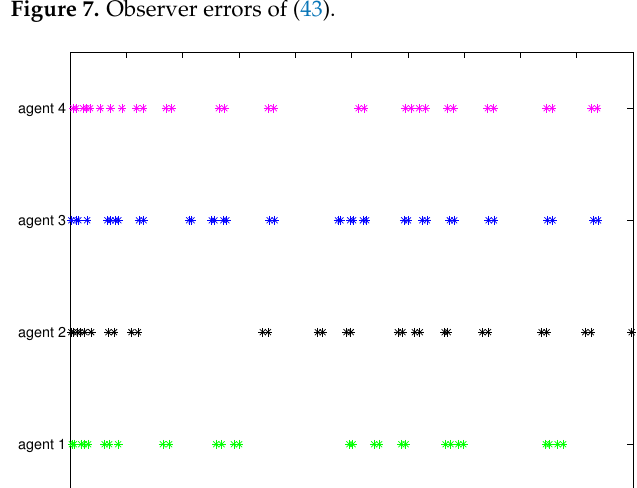
Figure 7. Observer errors of (43).